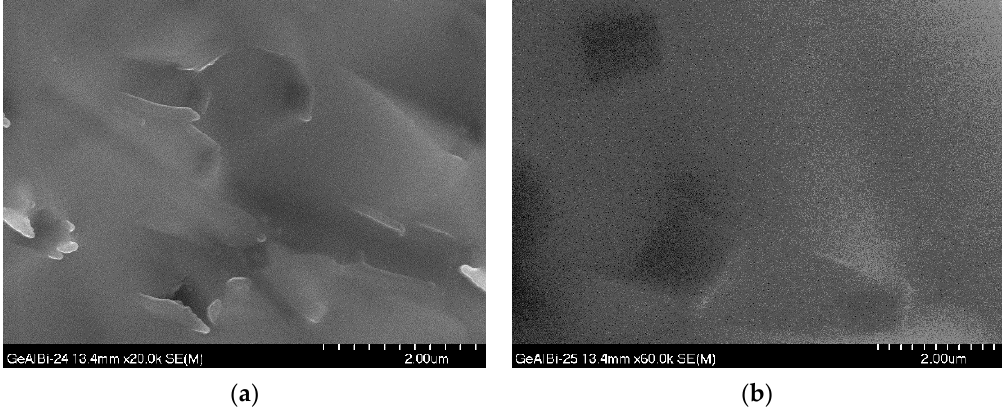
Figure 12. SEM micrographs of the 93GeO 2 –6Al 2 O 3 –1Bi 2 O 3 glass fractured surface after being heated at 600 °C observed with different magnification: ( a ) 20k, ( b ) 60k.